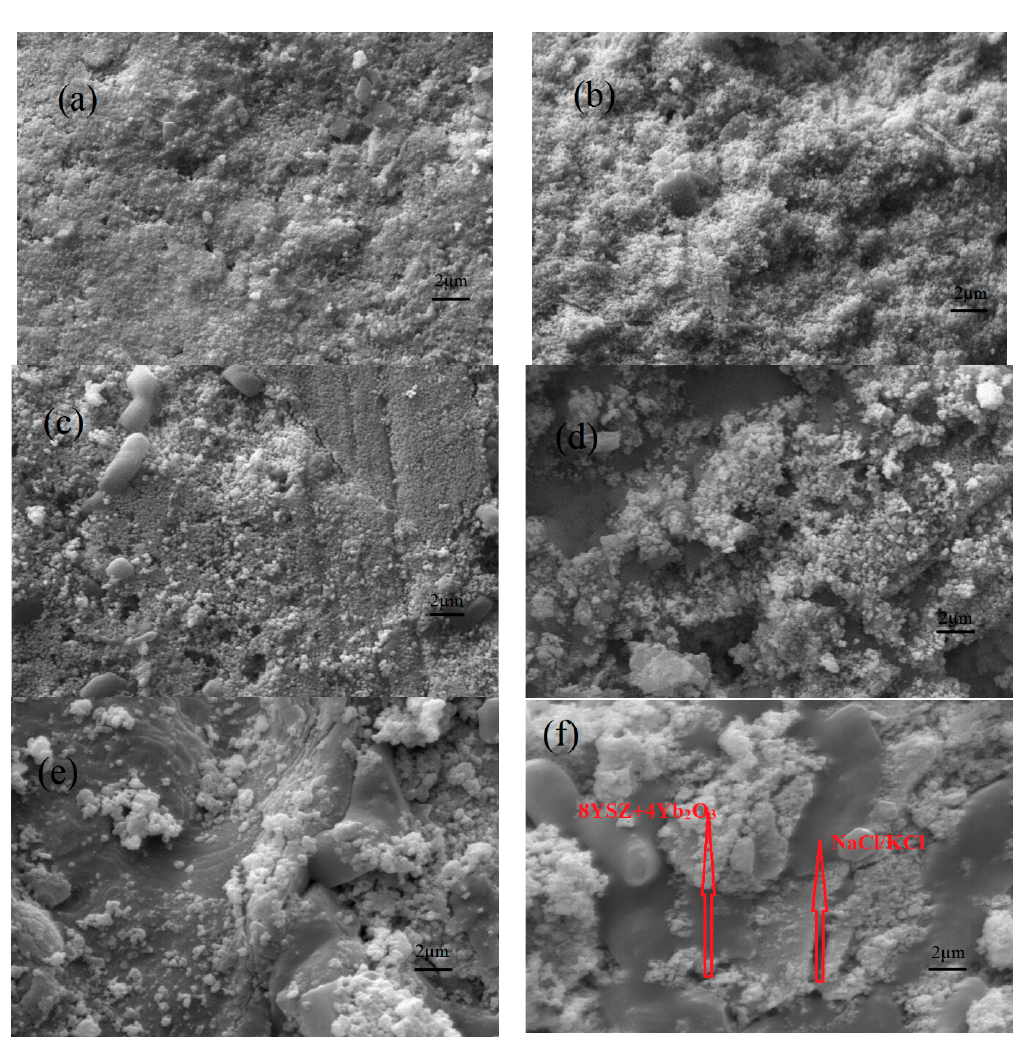
Figure 2. Surface ( a , c , e ) and cross-sectional ( b , d , f ) SEM images of the 8YSZ+4Yb 2 O 3 ( a , b ), 8YSZ+4Yb 2 O 3 -NaCl/KCl (1000 ◦ C) ( c , d ), and 8YSZ+4Yb 2 O 3 -NaCl/KCl (800 ◦ C) ( e , f )